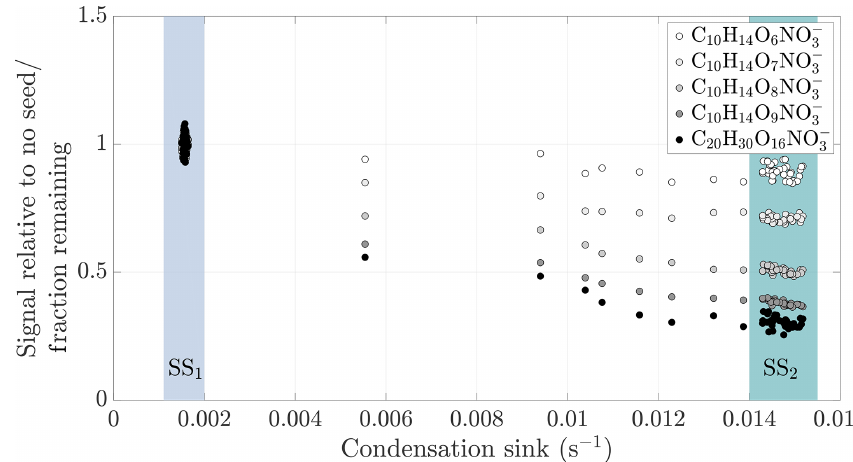
Figure 4. Gas-phase HOM signal normalized to level before seed injection vs. condensation sink during a typical experiment (experiment 19, same as in Fig. 2). The steady state before seed injection (SS 1 ) is visible as a cluster of points having a low condensation sink, and normalized gas-phase signals of around 1. The steady state formed during the seed injection (SS 2 ) is seen as distinct clusters of points at a higher condensation sink: the transition between the steady states is visible between these clusters. For each compound separately, we averaged the values during the seed injection steady state, and used these average values in the subsequent